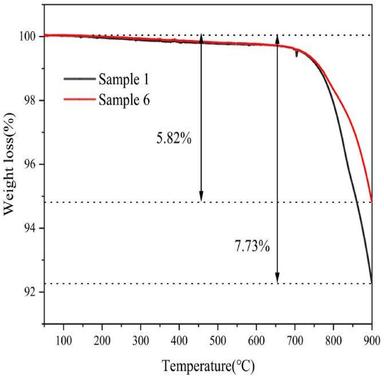
TGA spectra of BS and sample 6.